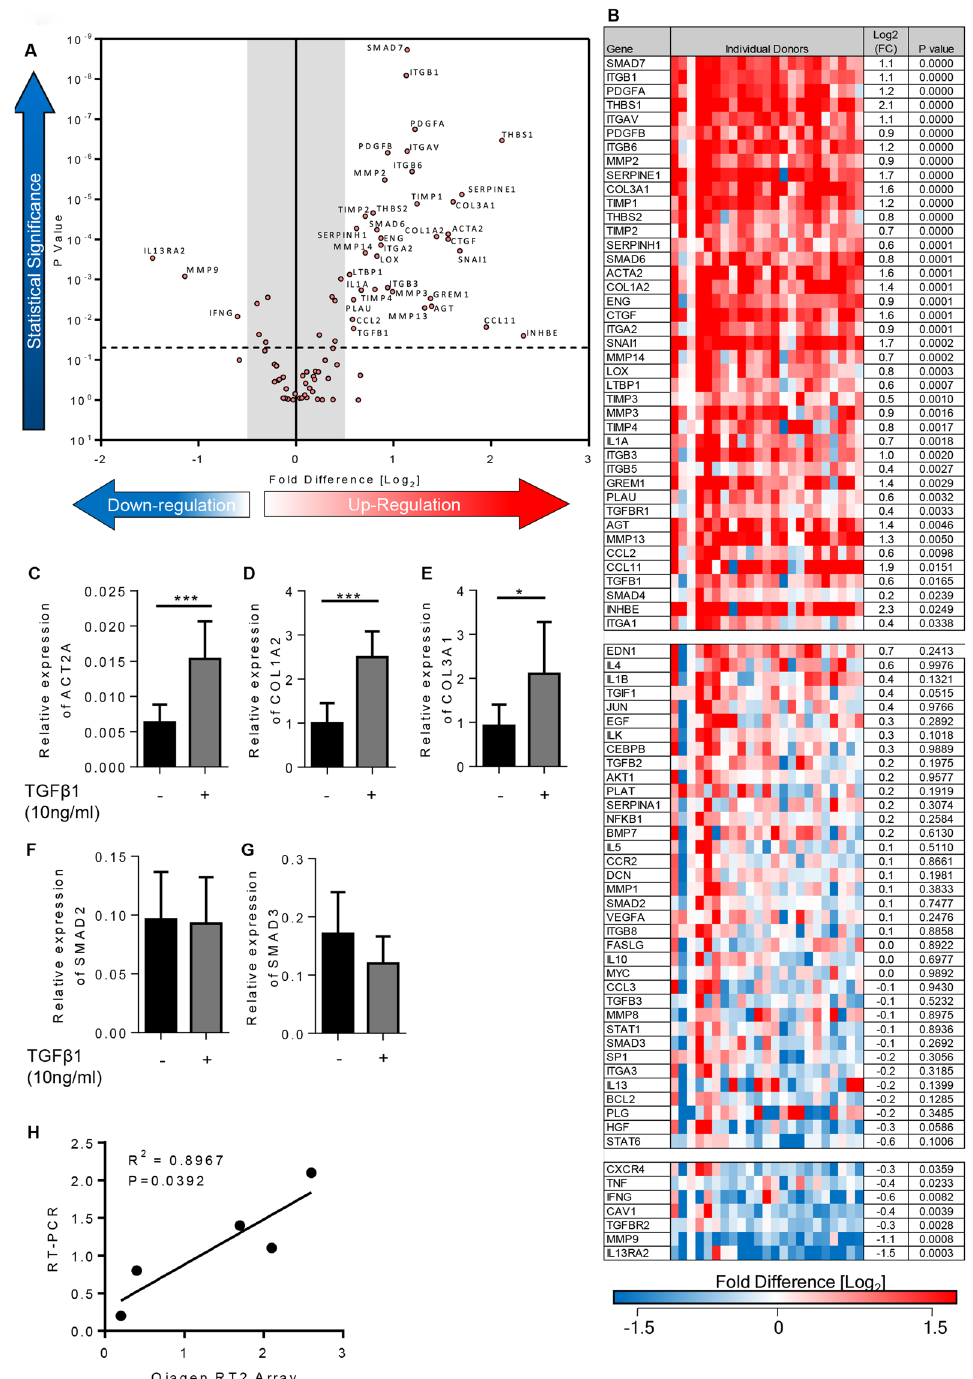
Figure 2. Differentially expressed genes in 7 day TGF β 1-stimulated lung tissue compared to control tissue. ( A ) Volcano plot identifying the statistically significant genes (p value) versus fold regulation (Log 2 (FC)) on the y and x axis respectively. Out of 84 genes, 41 were statistically significantly upregulated and 7 downregulated following a 5% false discovery analysis with John D. Storey adjusted p value < 0.05 and absolute value of log 2 (FC) ≥ 0.5, depicted by the dotted lines and grey shaded area (results are mean of 23 individual donors). ( B ) The log2 fold regulation of the 84 genes in individual donors is depicted in this heatmap, with mean log 2 (FC), and statistical significance indicated. Significance was calculated using a student’s t-test on the ∆∆ CT for each gene. ( C ) Relative expression of ACT2A ( α SMA mRNA) was significantly upregulated in TGF β 1- stimulated tissue in comparison to control tissue, P = 0.0010, n = 11. ( D ) COL1A2 (collagen type 1 mRNA) expression was significantly increased in TGF β 1-stimulated tissue in comparison to control, P = 0.0058, n = 11. ( E ) Relative expression of COL3A1 (collagen type III mRNA) was significantly upregulated in TGF β 1- stimulated tissue, P = 0.0296, n = 12. ( F ) SMAD2 mRNA expression was not significantly changed